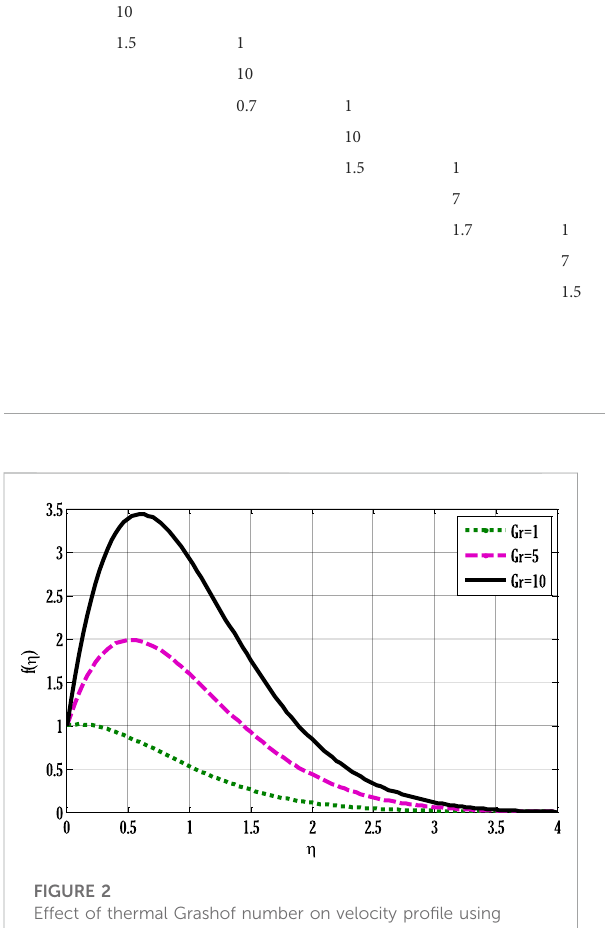
(cid:1) 0 . 4 , β (cid:1) 0 . 4 , P r (cid:1) 0 . 7 , R d (cid:1) 1 . S c (cid:1) 1 2